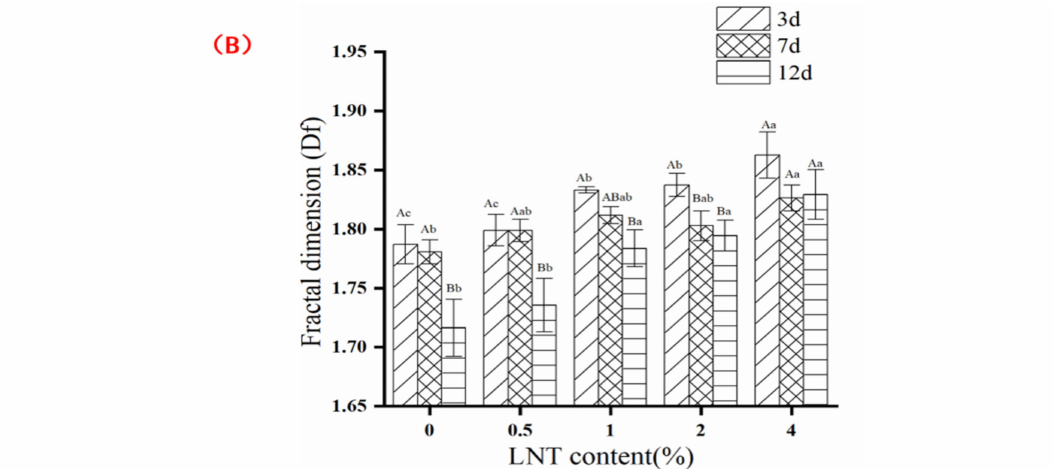
Figure 3. ( A ) Microstructure of goose meatballs and their corresponding binarized images with LNT content and storage time during cold storage (4 ◦ C). The first number 3, 7, 12 represents the storage days, and the second number 0, 0.5, 1, 2, 4 represents the content of LNT. ( B ) Fractal dimension (Df) calculated using the box counting method from SEM binary images of goose meatballs. Capital letters indicate significant differences between different storage times for the same sample ( p ≤ 0.05). Lowercase letters indicate significant differences between different contents of LNT sample during the same storage time ( p ≤ 0.05).